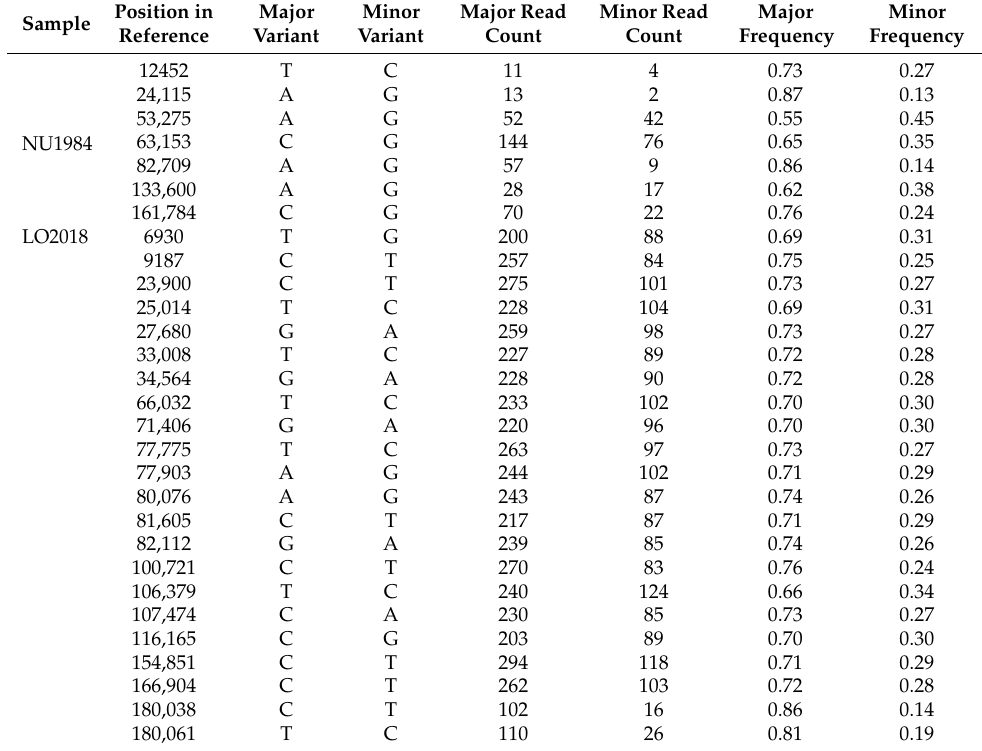
Table 1. Position with respect to the reference sequence KX354450, major and minor allele and their read counts for all intermediate variants, in NU1984 and LO2018